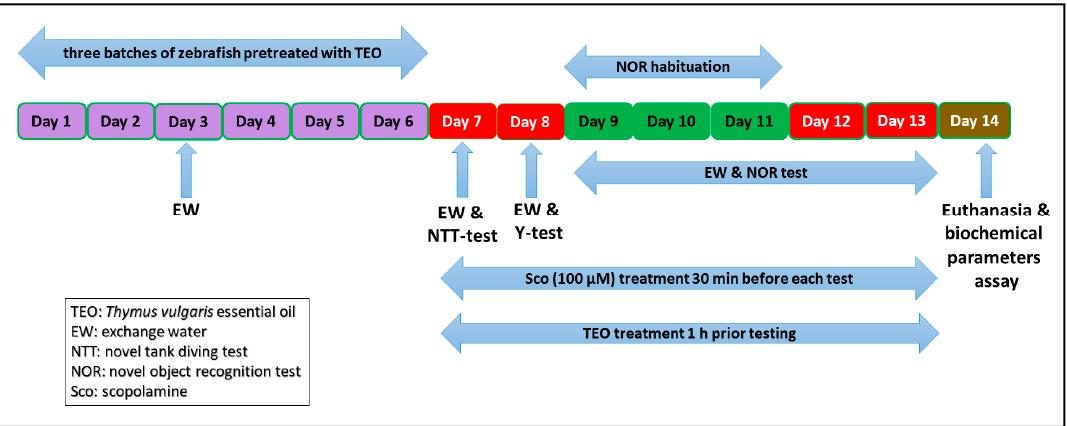
Figure 1. Experimental design procedure for the Thymus vulgaris essential oil administration, behavioral study, and biochemical analysis.